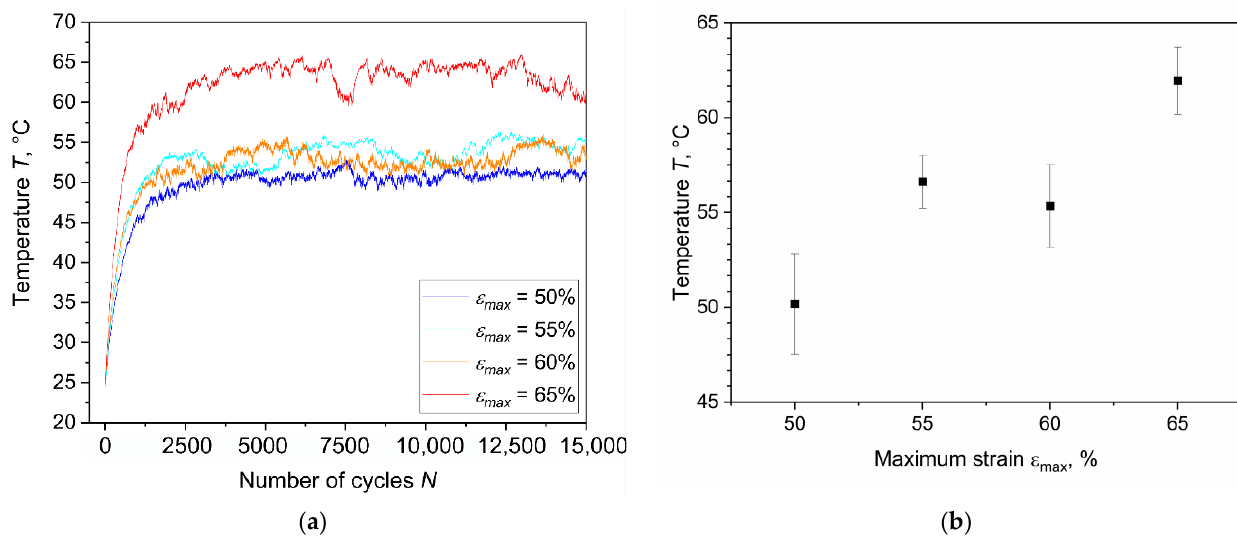
Figure 4. ( a ) Surface temperature evolution at different strains in the first 15,000 cycles of the fatigue experiments; ( b ) average values of plateau temperatures at different strains obtained during fatigue experiments from three samples per condition. The fatigue tests were implemented on axisymmetric dumbbell specimens of CB filled NBR at a frequency of 4 Hz and load ratio R ε of 0.5.